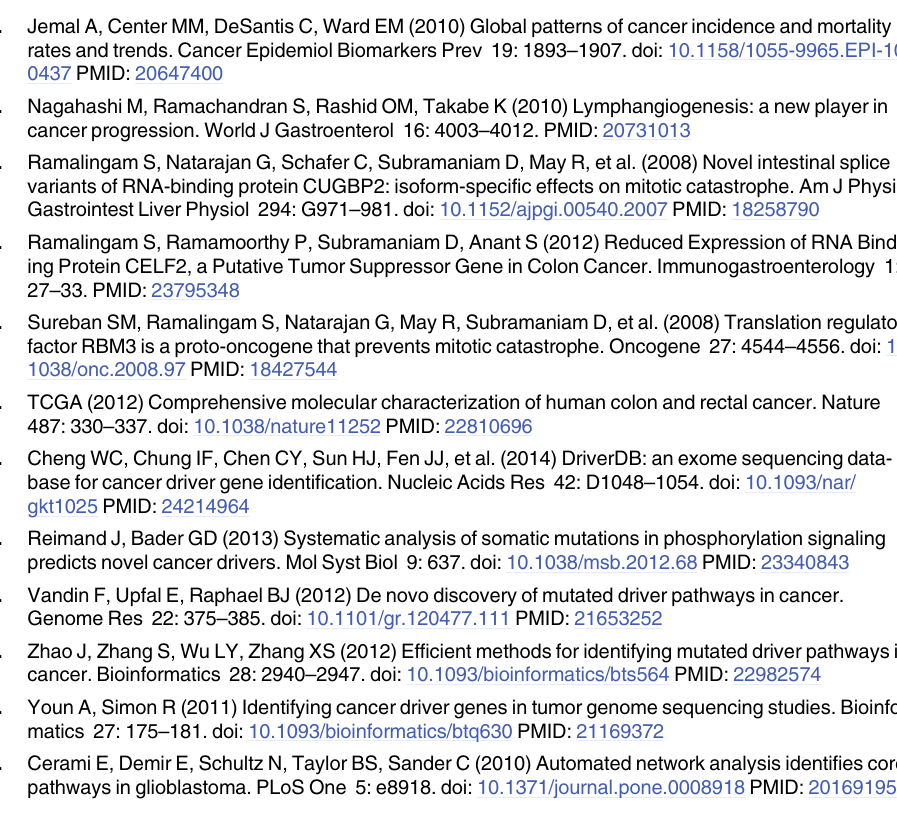
S1 Table. Stagewise novel driver genes used in network construction. S2 Table. Power-law behavior of the node distribution of all the stage-specific networks. S3 Table. Summary of topological parameters of all the stage-specific